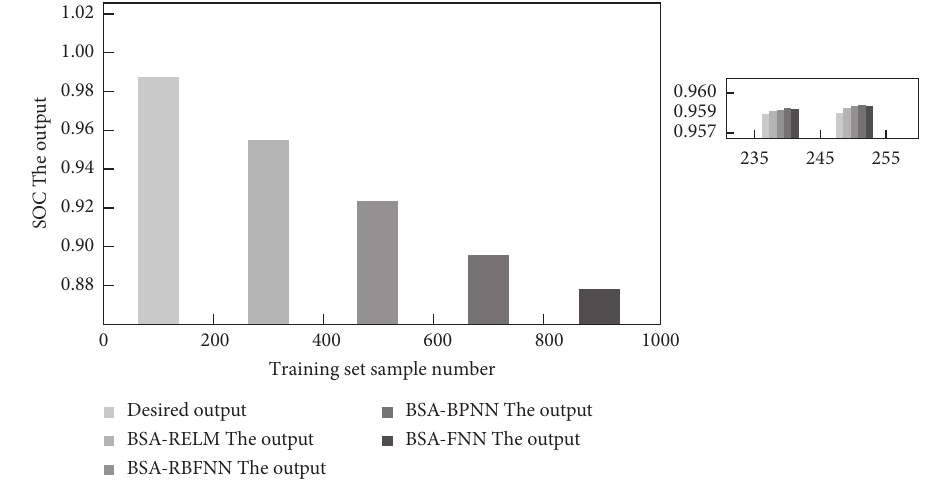
Figure 10: Training results of four algorithms. Table 1: Training errors of various networks.